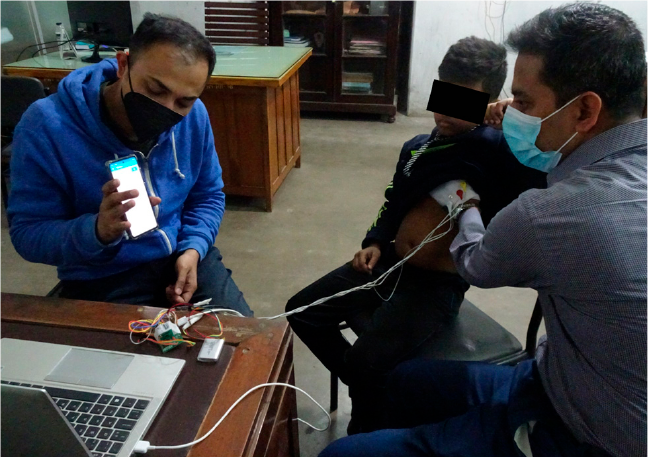
Figure 14. RR measurement on an 8-year-old volunteer at the Department of Biomedical Physics and Technology, University of Dhaka, Bangladesh.